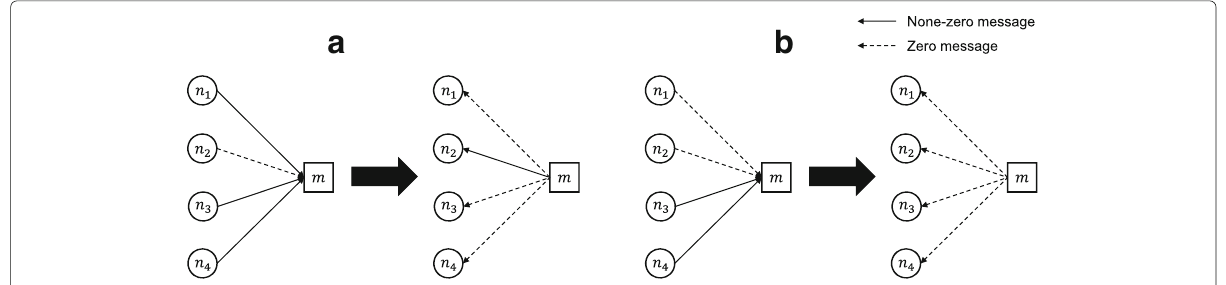
Fig. 7 Effects of zero V2C LLRs on check node operations. Dashed lines represent zero-LLR V2C or C2V messages. a The case where one zero V2C LLR is received. b The case where two zero V2C LLRs are